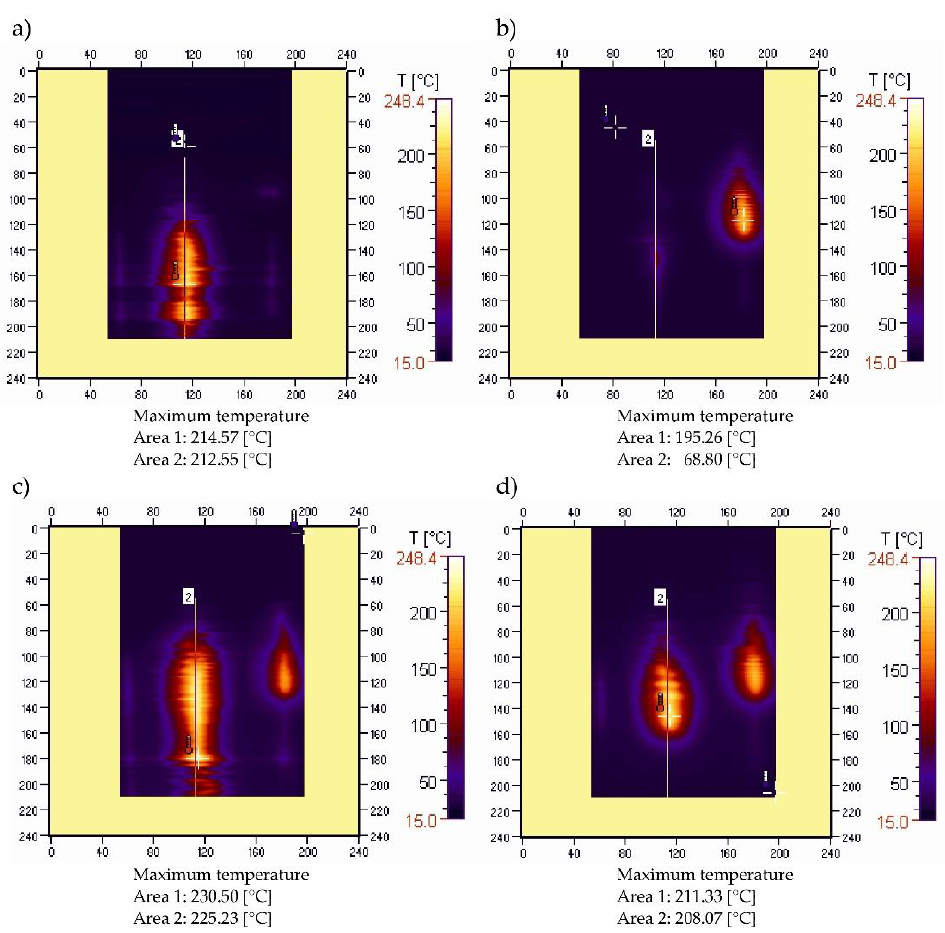
Figure 11. Thermograms of unmodified PE ( a ), PBS ( b ), PE ( c ), and PBS ( d ) samples, containing 50% filler content.